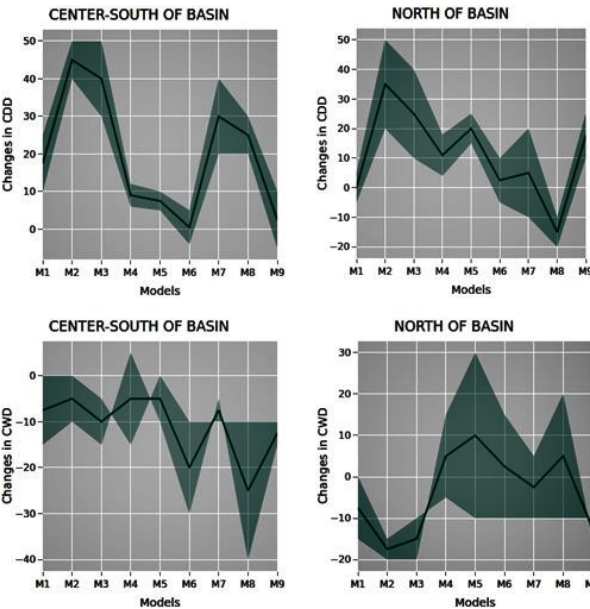
Figure 3. Mean consecutive wet days (CWD) and Mean consecu- tive dry days (CDD) changes between far future (2071–2100) and historical period (1971–2000) during May to September for models: (M1) CNRM-CM5, (M2) MIROC5, (M3) EC-EARTH, (M4) IPSL- CMA5-MR, (M5) MPI-ESM-LR, (M6) GFDL-ESM2M, (M7) NorESM1-M, (M8) CanESM2 and (M9) Models-Mean (ensemble mean of